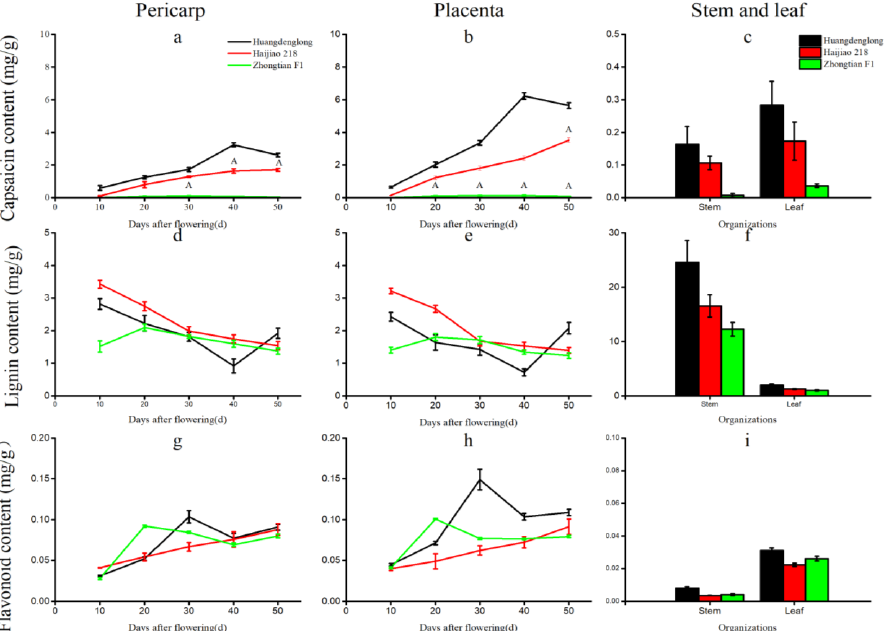
Figure 7. Comparison of capsaicin, lignin, and flavonoids in different tissues at different stages. Note: ( a , b , d , e , g , h ) The abscissa is the days after flowering, and the ordinate is the content of capsaicin/lignin/flavonoids in pericarp and placenta of different peppers. ( c , f , i ) The abscissa is different organizations, and the ordinate is the content of capsaicin/lignin/flavonoids in organizations of different pepper varieties.